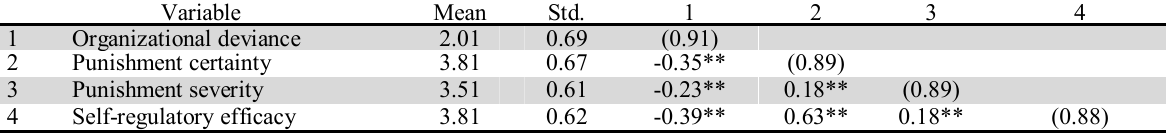
Means, standard deviations, reliabilities, and correlations between variables